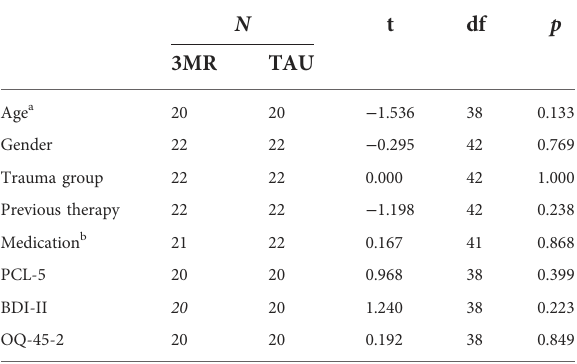
TABLE 2 Independent samples t-test baseline (pre) differences between 3MR and TAU